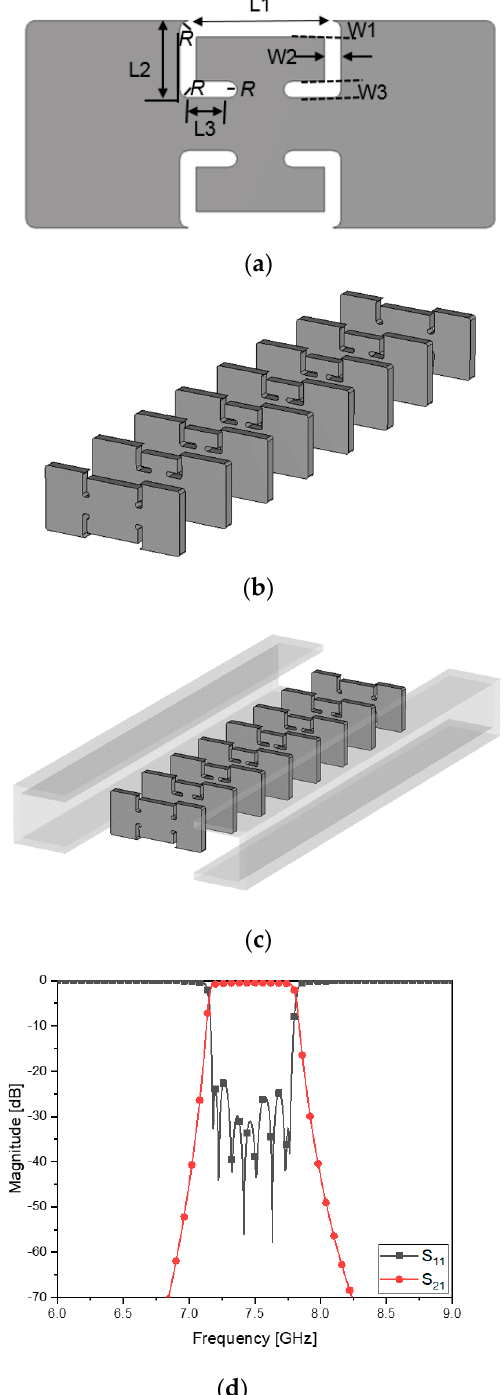
Figure 7. Realistic geometry of the eighth − order WG ZOR BPF. ( a ) Front-view of the thin resonator with the round corners. ( b ) and ( c ), 3D structure. ( d ) S 11 and S 21 .